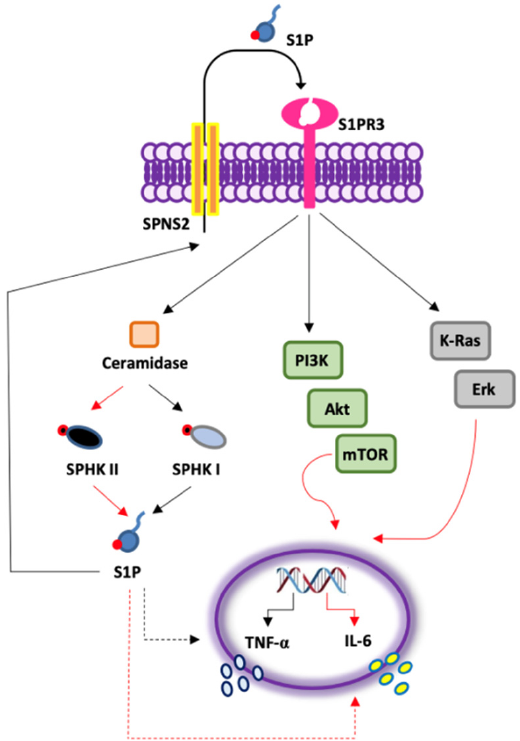
Figure 6. S1P exacerbates the pro-inflammatory milieu by inducing pro-inflammatory cytokine release from lung cancer-derived PBMCs in a S1PR3-dependent manner. The activation of S1PR3 by the exogenous S1P enhances its own production and fosters the release of TNF- α in a SPHK I-dependent manner (black arrows), and of IL-6 via SPHK I/II (red arrows); S1P-induced IL-6, but not TNF- α , release from PBMCs of lung cancer patients is mTOR- and K-Ras-dependent (red